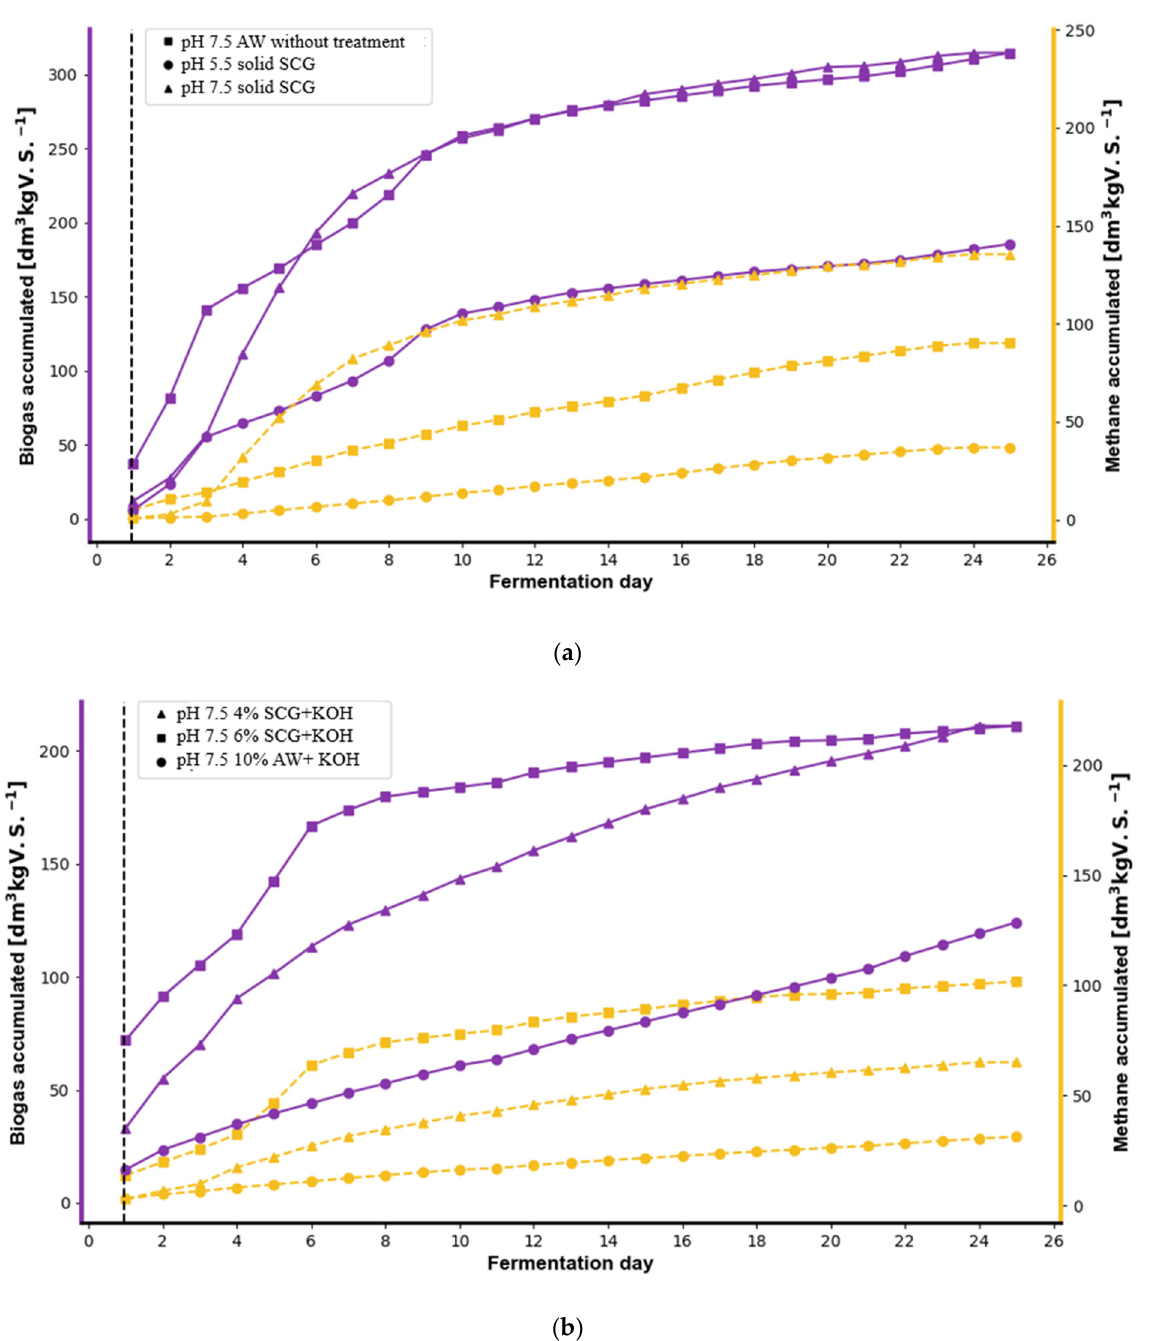
Figure 2. Accumulation of biogas (violet) and methane (yellow) during 25 days of fermentation during utilization of ( a ) untreated and ( b ) pretreated SCG and